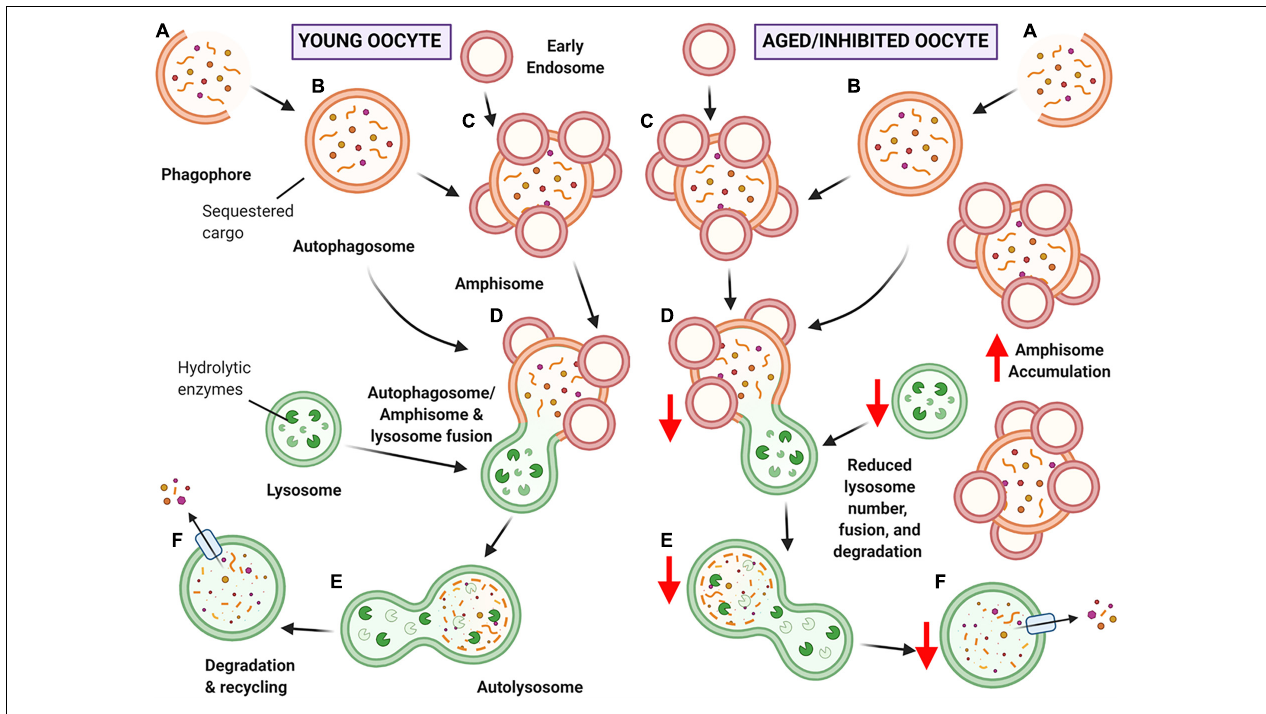
FIGURE 11 | Schematic of hypothesized ‘bottleneck model’ of macroautophagy in aging or chloroquine treated oocytes. (A) Macroautophagy begins with the formation of the phagophore, and as it continues to grow and sequester cargo, it forms a completed double-membraned vesicle termed the autophagosome, encompassing the cargo to be degraded (B) . Based on our data, the autophagosome may then fuse with early endosomes to create amphisomes (C) . The autophagosome or amphisome can then fuse with the acidic lysosome containing hydrolytic enzymes (D) to form an autolysosome (E) in which the encapsulated cargo is broken down into its basic building blocks. Lastly, the broken down cargo is extruded back into the cell cytoplasm for recycling (F) (Feng et al., 2014; Klionsky et al., 2016). In young oocytes (left-hand panel) this process is hypothesized to occur normally. In aged or chloroquine treated oocytes (right-hand panel), the availability of lysosomes is decreased, resulting in less lysosomal fusion with autophagic vesicles and ultimately reduced protein degradation. Due to the bottleneck created by the reduced lysosomal availability (due to decreased numbers in aging or loss of functionality with inhibition) an accumulation of large amphisomes is observed. Created with